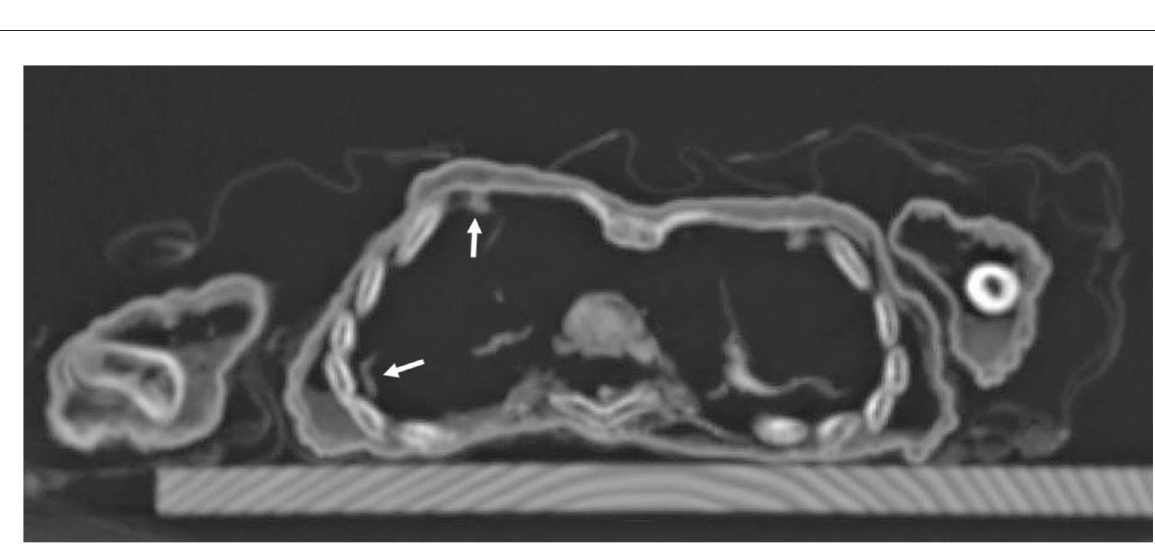
lipid modification under wet and air-tight conditions (such as in coffins, underwater, or within, for example, a